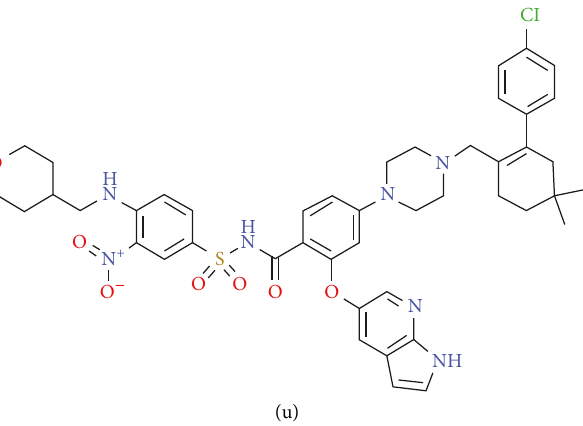
Figure 1: Molecular structures of breast cancer drugs. (a) Alpelisib. (b) Azacitidine. (c) Cytarabine. (d) Daunorubicin. (e) Dexamethasone. (f) Docetaxel. (g) Doxorubicin. (h) Glasdegib. (i) Gilteritinib. (j) Ivosidenib. (k) Midostaurin. (l) Olaparib. (m) Paclitaxel. (n) Palbociclib. (o)